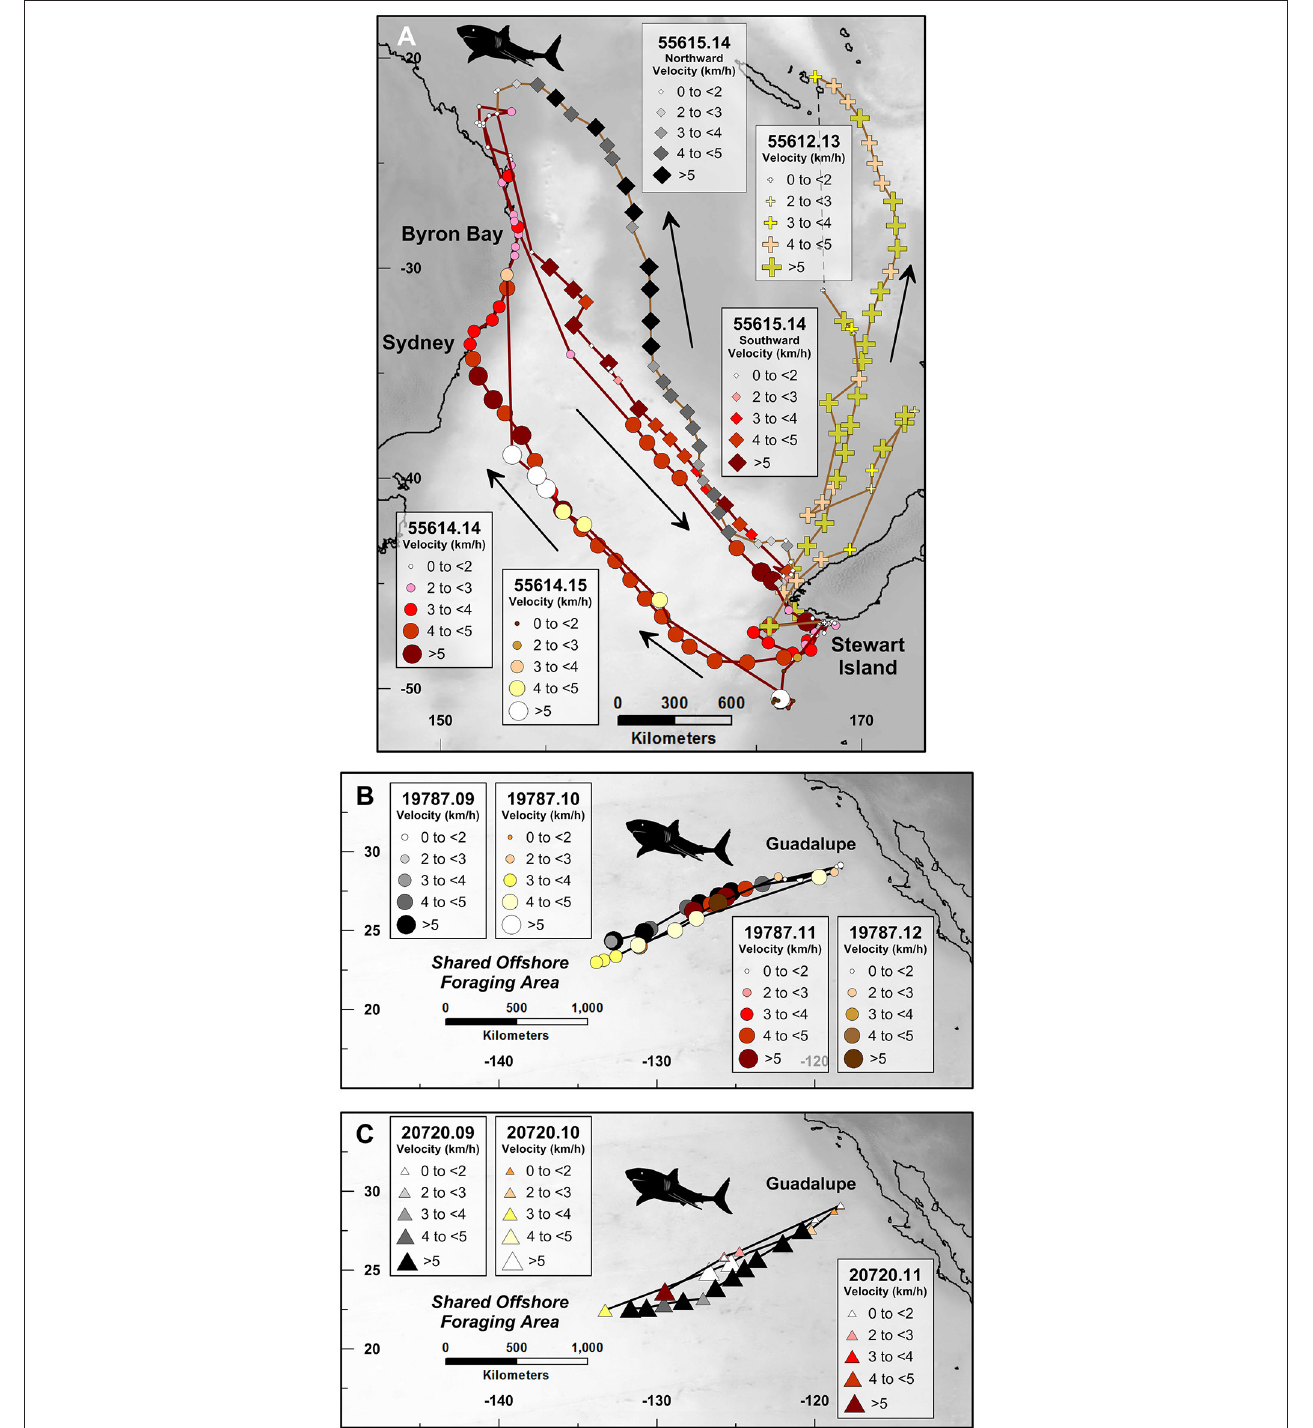
FIGURE 2 | Route fidelity and non-route fidelity movements of satellite-monitored great white sharks, including: (A) great white sharks in the South Pacific Ocean, (B,C) great white sharks in the North Pacific Ocean. Symbol sizes and color hue correspond with average daily track velocity (km/h) as shown in the legends. Unique platform transmitting terminal (PTT) tag numbers to the left of the PTT number decimal point correspond with individual sharks and are represented by symbol shape; digits to the right of PTT number decimal point correspond with the abbreviated year in which the whale was tagged and are represented by symbol color family (i.e., red, yellow, brown, etc.). Addition (PTT 55612.13) and black/gray diamond (PTT 55615.14) symbols in (A) correspond with long-distance non-route fidelity migrations.